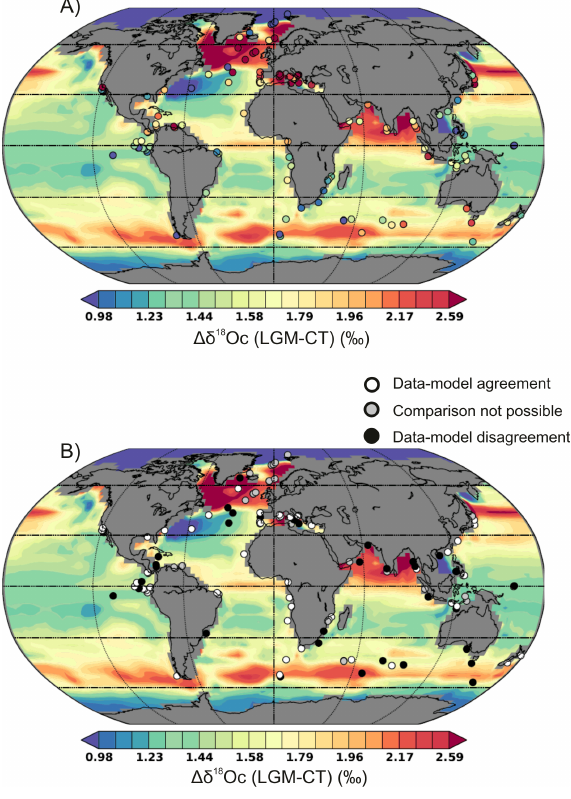
Figure 8. (a) Comparison between simulated surface ocean calcite δ 18 O anomaly (LGM-CT) in i LOVECLIM (0–50m) and global planktic foraminifera data (Table S1). (b) Quantitative agreement or disagreement between simulated surface ocean calcite δ 18 O anomaly (LGM-CT) in i LOVECLIM (0–50m) and global planktic foraminifera data (Table S1), taking into account the uncertainties on calcite δ 18 O data (2 σ) . Grey points (comparison not possible) denote the absence of error bars on data or denote locations where model results are not comparable to data (coastal sites). For colour scale generation explanations see Fig. 1